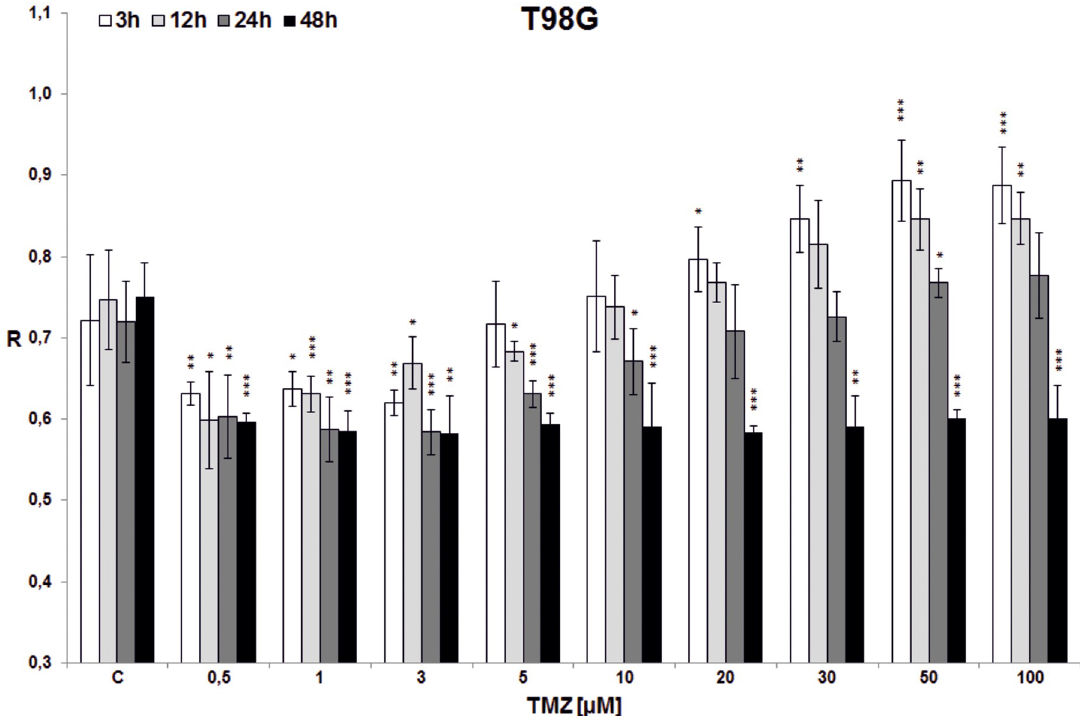
Fig 3. The effect of TMZ on total DNA methylation of T98G cell line. The analysis was performed after 3 (white bars), 12 (light grey bars), 24 (dark grey bars) and 48 (black bars) hrs of incubation in a given TMZ concentration (0.5–100 μ M). Control cells (C) were treated with DMSO only. The R values are means from three experiments ± SD. Asterisks indicate a significant difference ( � p < 0,05, �� p < 0,01, ��� p < 0,001) from the control (DMSO) value. Striking DNA hypomethylation happens in therapeutically achieved concentrations (less than 5 μ M). Significant DNA hypermethylation is achieved at minimal TMZ concentrations of 20–50 μ M in 3–24 hrs incubation time. Clear demethylating tendency is seen with 48 hrs incubation time in all TMZ concentrations.